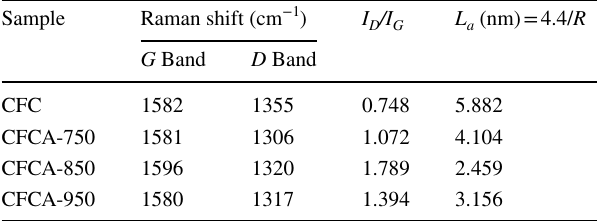
Table 2 Raman analysis- I CFC and CFCAs